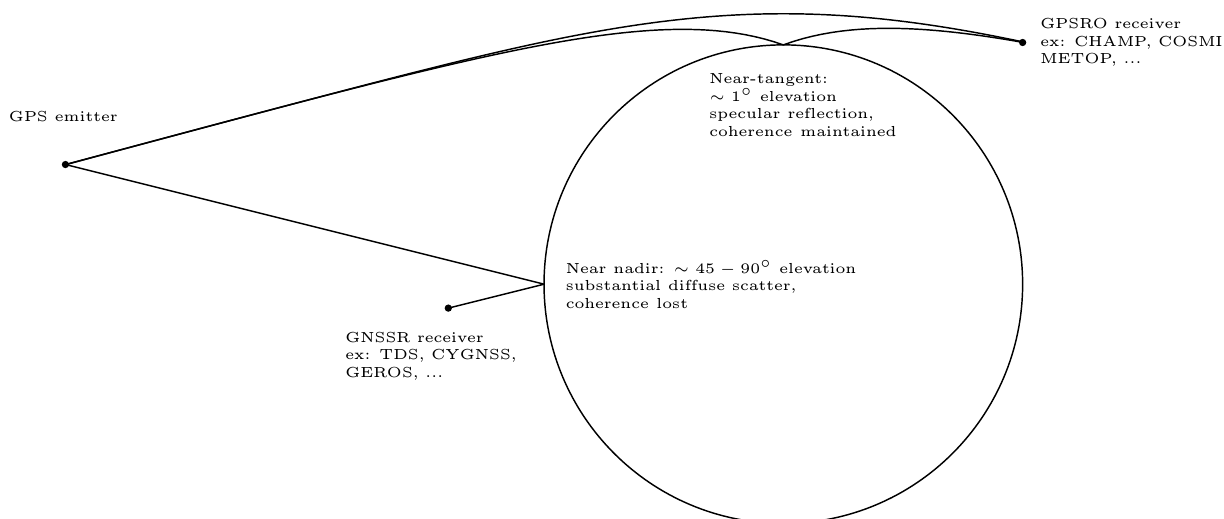
Figure 1. Diagram showing the concept of atmospheric occultation together with the grazing reflection during the occultation, which is the focus of this study (upper part of the diagram). For comparison, the concept of GNSS reflections (GNSSR), at a higher elevation angle, is shown on the left. At very low elevation angles the coherence of the emitted signal is often not lost even if the signal bounces off a surface that is not perfectly smooth (for instance ocean waves, see main text). During a reflection at a high elevation angle, which is the concept behind several recent missions (e.g. TDS, CYGNSS, GEROS), normal ocean waves destroy